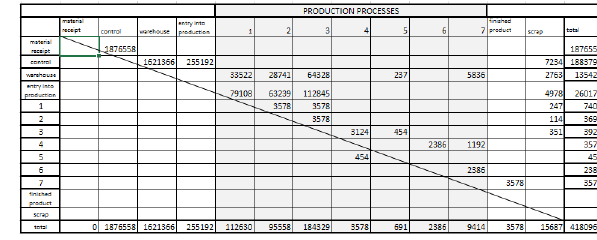
Table 1: The flows of material in pieces